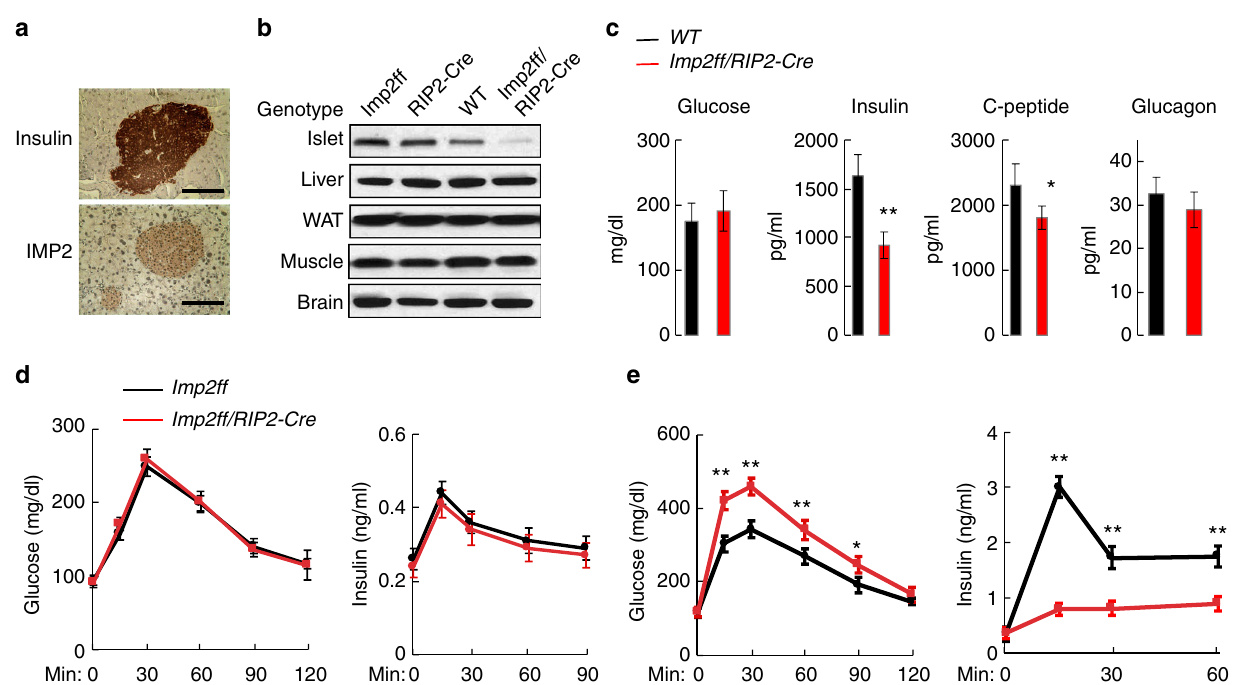
Fig. 5 Loss of Imp2 activity in mouse beta cells impairs glucose-stimulated insulin secretion in diet-induced insulin resistance. a Immunostaining of insulin and IMP2 in mouse pancreas. Scale bar equals 80 μ M. b Expression of IMP2 in islets and other T2D-relevant tissues liver, adipose, muscle, and brain. The original uncropped images are provided in the source data fi le. c Blood glucose, insulin, c-peptide, and glucagon level in 10-week-old male mice on high-fat diet (HFD) ( N = 9). Wild-type (black) and Imp2ff/RIP2-Cre (red). d One-gram per kilogram of glucose was administered intraperitoneally after overnight fasting of 12-week-old Imp2ff (black; N = 10) and Imp2ff/RIP2-Cre (red; N = 10) male mice maintained on normal chow diet (NCD). left = blood glucose; right = serum insulin. e One-gram per kilogram of glucose was administered intraperitoneally after overnight fasting to 12-week-old Imp2ff (black; N = 9) and Imp2ff/RIP2-Cre (red; N = 9) male mice maintained on HFD. left = blood glucose; right = serum insulin. Values represent mean and SD. T -test * P